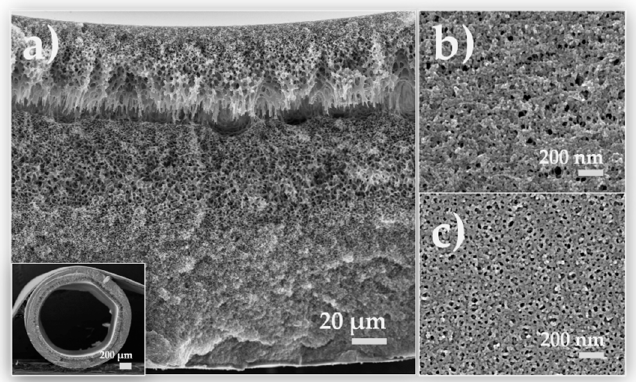
Figure 16. Exemplary porous structure of DLHF AS 9. ( a ) shows a magnification (356 × ) of the cross section (complete cross section with magnification of 40 × in the inset) and the transient region between the support and the additive layer. At magnifications of 50,000 × ( b ) depicts the inner pore distribution, while ( c ) features the outer porous structure.